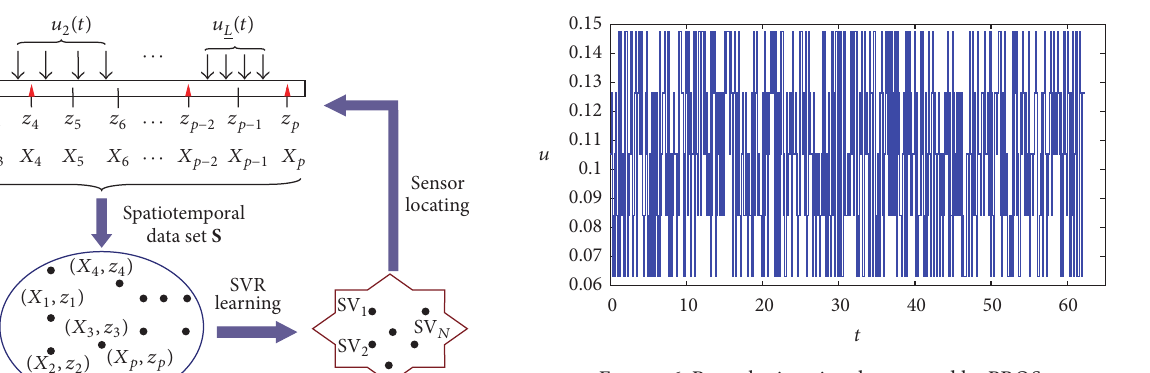
Figure 6: Perturbation signal generated by